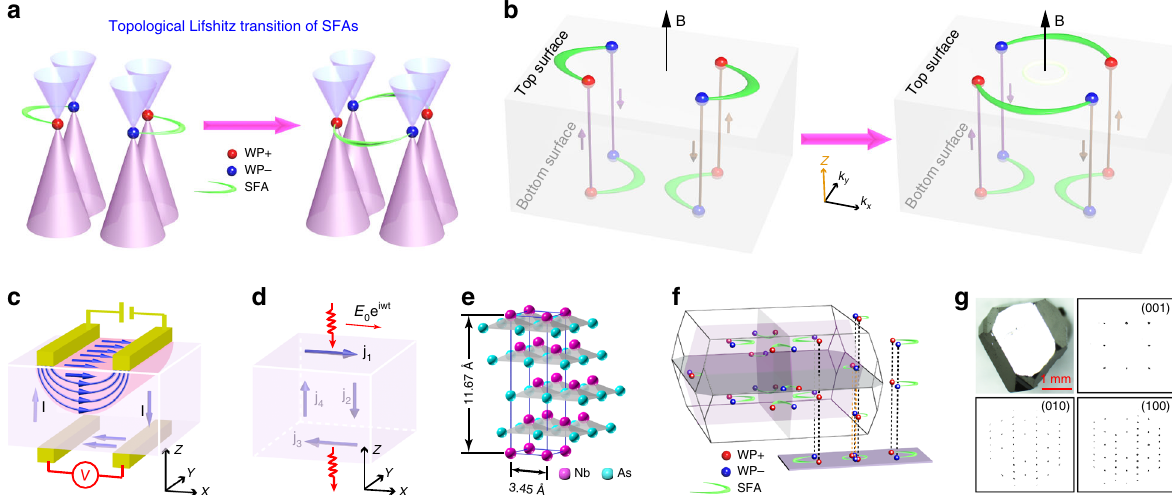
Fig. 1 Topological Lifshitz transition of SFAs and characterization of NbAs crystals. a Sketch of topological Lifshitz transition of SFAs in TWSs. Balls and green crescents represent Weyl points and Fermi arcs, respectively. b Schematic illustration of Weyl orbits that weave together chiral bulk states and SFAs of top and bottom surfaces in magnetic fi elds. When a topological Lifshitz transition of SFAs occurs at the top surface, the Weyl orbits and relevant quantum phenomena change, thus modifying the physical responses of TWSs. c Schematic illustration of non-local voltage generation 21 . d Schematic illustration of unusual electromagnetic wave transmission 21 . e Sketch of the NbAs crystal structure, showing a body-centered-tetragonal structure without inversion symmetry. f Bulk and projected surface Brillouin zones (BZs) with Weyl points connected by SFAs. g Optical image of a typical NbAs crystal and X-ray diffraction patterns along the (001), (010), and (100) crystalline